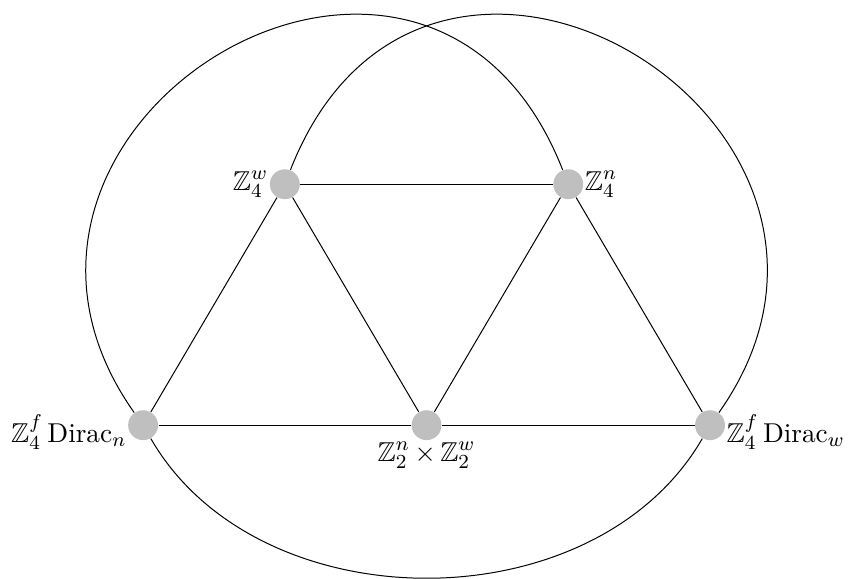
Figure 12 . Orbifolding a non-anomalous Z 2 subgroup of a theory with a Z 2 × Z 2 symmetry and mixed anomaly produces a theory with Z symmetries to produce two theories with Z f we can form the complete orbifold